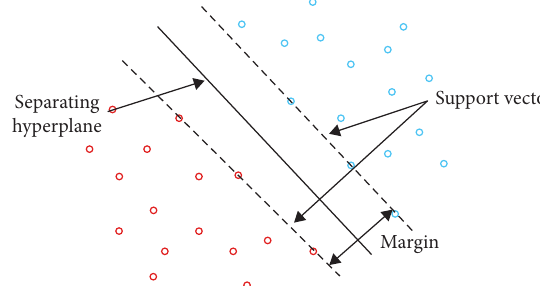
Figure 1: Linearly separable